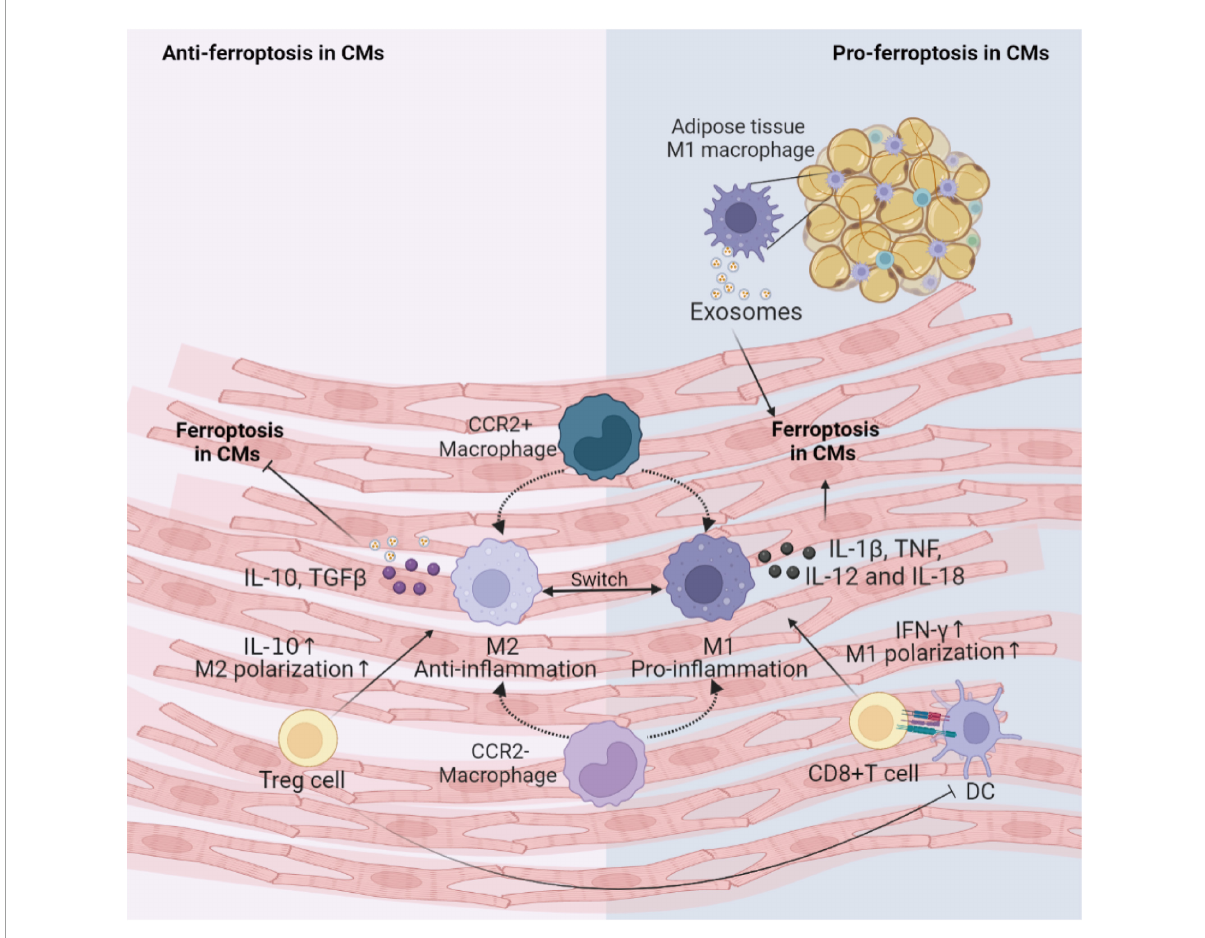
FIGURE3 Immune cells involved in the regulation of CMs ferroptosis. This figure summarizes macrophages and T cells activity regulating the ferroptosis following cardiac injury. The cross-talk between these immune cells and CMs depends on various inflammatory factors and exosomes. DC, dendritic cell; CM, cardiomyocyte; IL, interleukin; TNF, tumor necrosis factor; IFN, interferon; TGF, transforming growth factor; CCR, C-C motif chemokine receptor